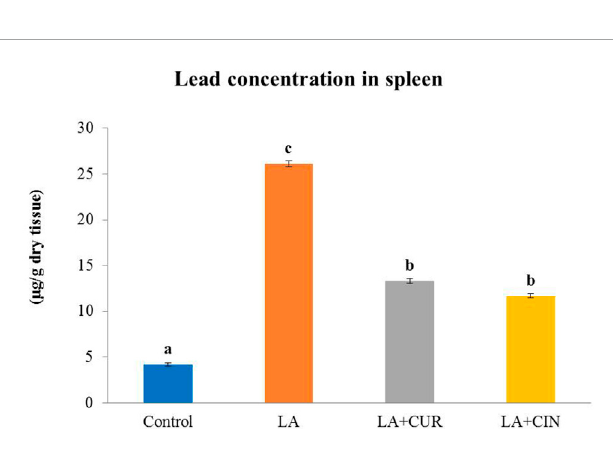
FIGURE 6 Lead concentration in the splenic tissue of different treatment groups compared with the control (mean ± SE). Different superscripts (A – C) in each fi gure indicate signi fi cant differences at p < .05.